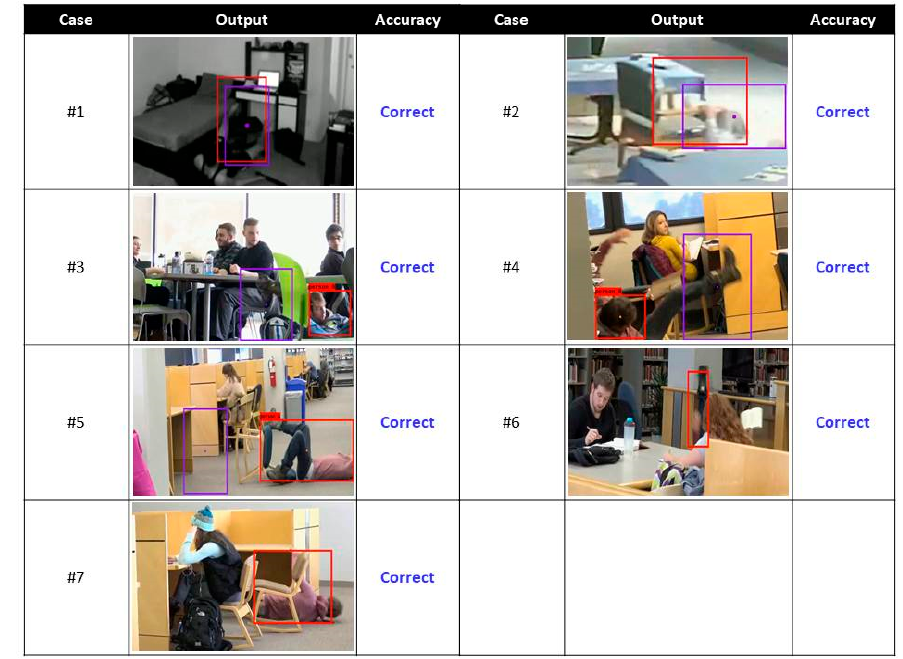
Figure 1 8 . The results of the video case studies of falls while sitting.